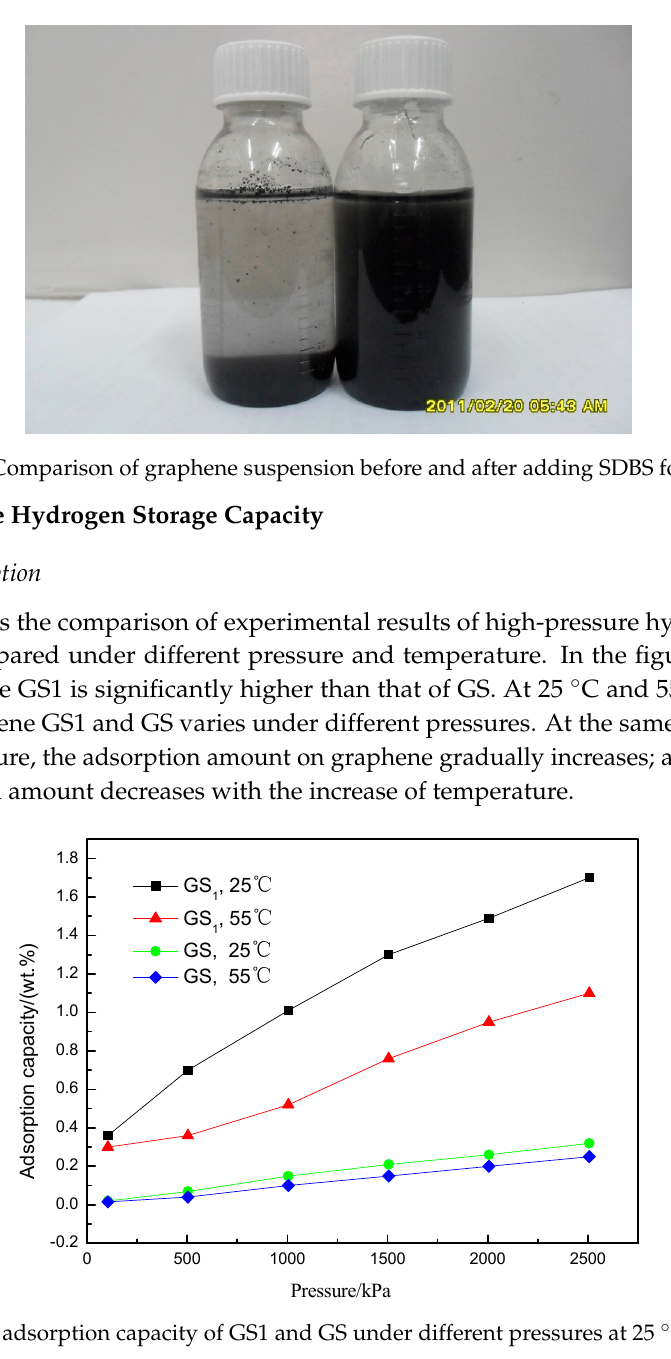
Figure 12. H 2 adsorption capacity of GS1 and GS under different pressures at 25 °C and 55 °C.